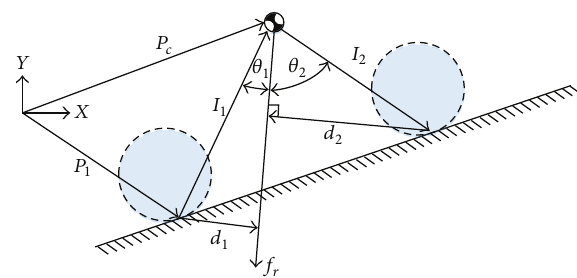
Figure 3: Planar force-angle stability metric.